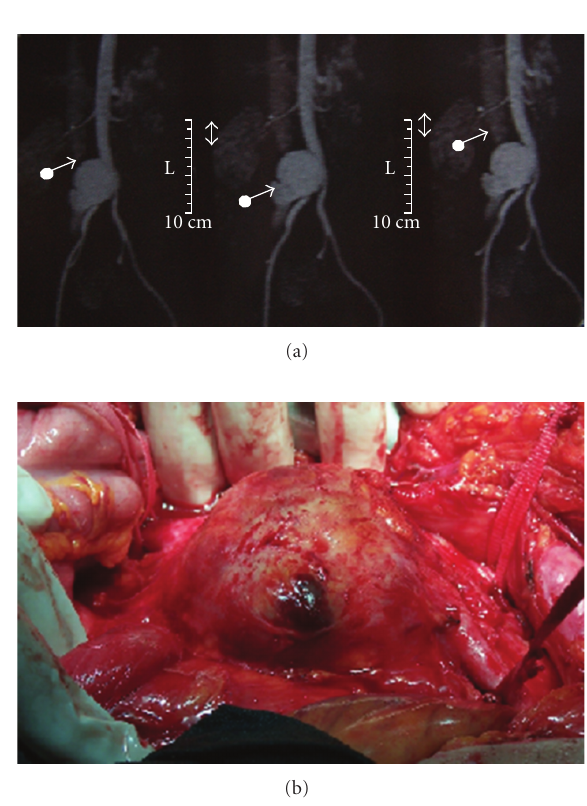
Figure 1: (a) MRI of abdominal aortic pseudoaneurysm showing a small amount of aortacaval connection. (b) Operative image of